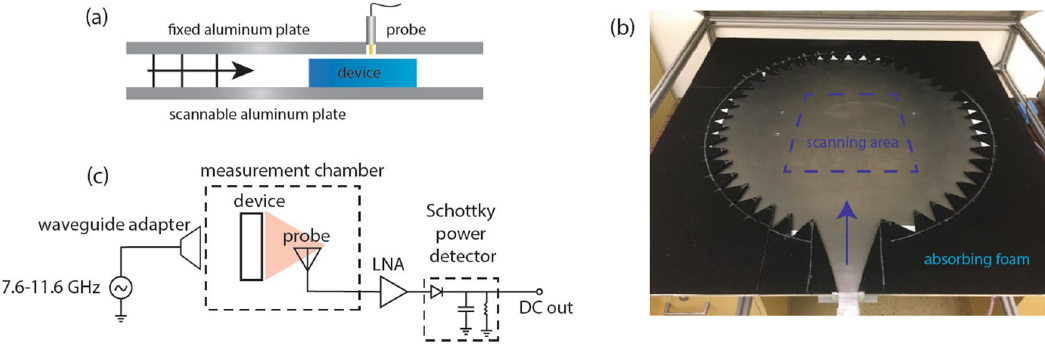
Figure 1. The anechoic chamber used to measure the 3D printed devices. ( a ) A sideview of the chamber. A TEM mode is injected into the anechoic chamber, exciting the device at approximately normal incidence. The fields in the cavity, including fields above the device, are measured with a small antenna probe extending through the top aluminum plate. The bottom aluminum plate is scanned in two directions to make a full 2D scan. ( b ) A picture of the anechoic chamber with the top aluminum plate removed. The scanning area is surrounded by absorbing foam. Triangles were cut out of the absorbing foam to reduce reflections. ( c ) A schematic representation of the measurement setup. The microwave source (Windfreak SynthHD) is scanned from 7.6 to 11.6 GHz and is injected through a waveguide adapter. The signal from the measurement probe